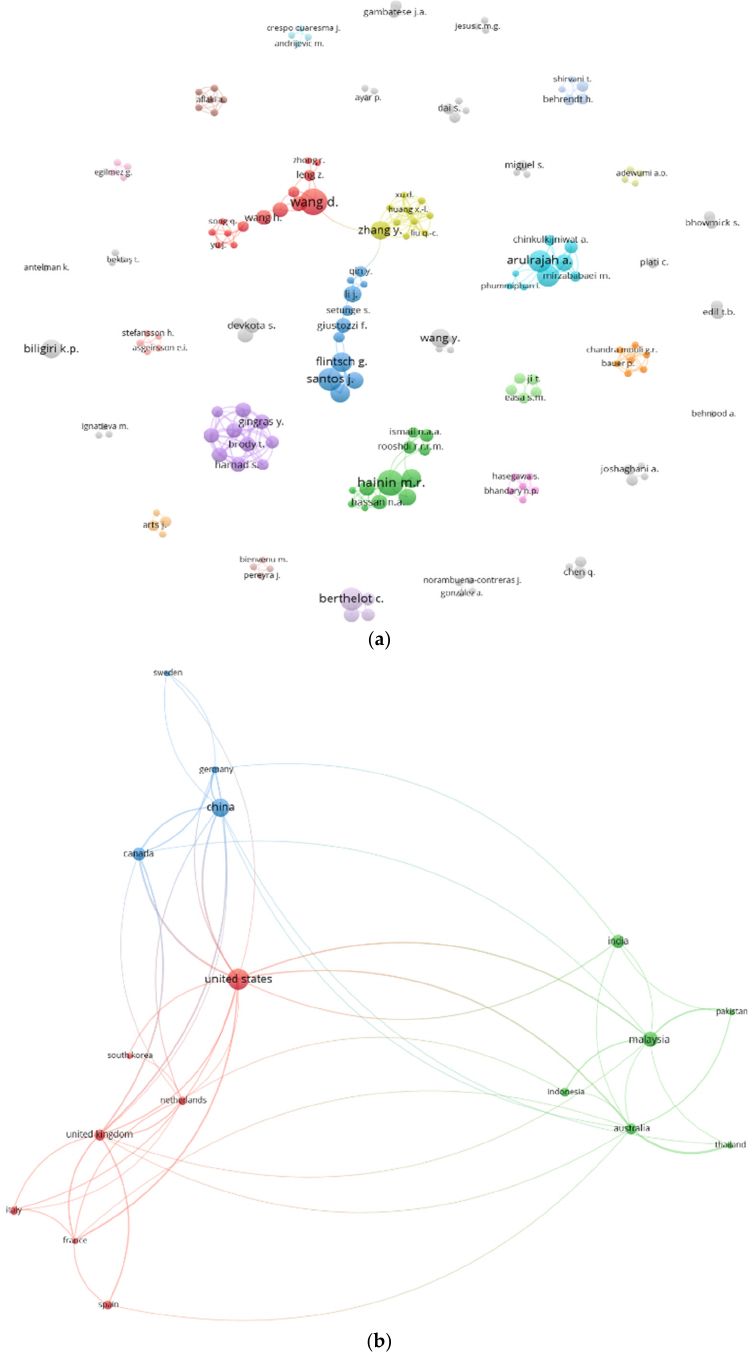
Figure 5. Network visualisation co-authorship with minimum 35 citations ( a ) and by countries with minimum 10 citations ( b